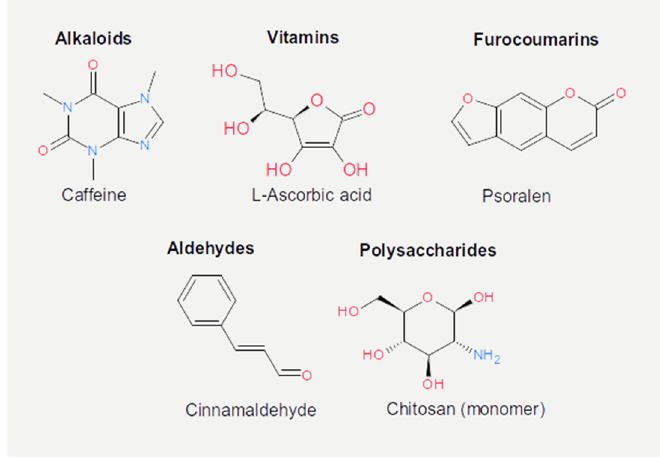
Figure 4. Chemical structures of the flavonoids reported in the present review.